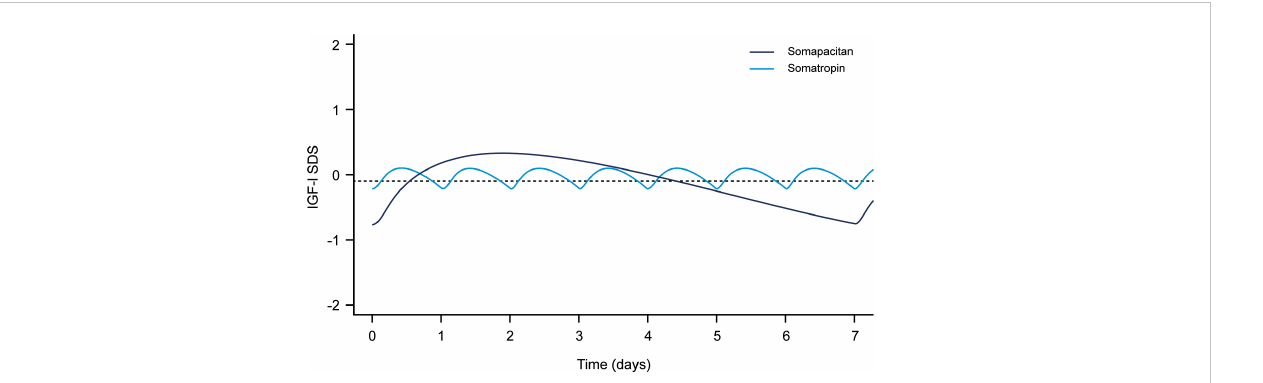
FIGURE 1 Simulated weekly IGF-I SDS levels following dosing with somapacitan (weekly GH [mean dose 2.4 mg]) and somatropin (daily GH [mean dose 0.3 mg]). Dashed line is weekly average IGF-I SDS for somapacitan (-0.09 SDS). Reproduced from Bentz Damholt et al. (24) under the CC BY-NC license